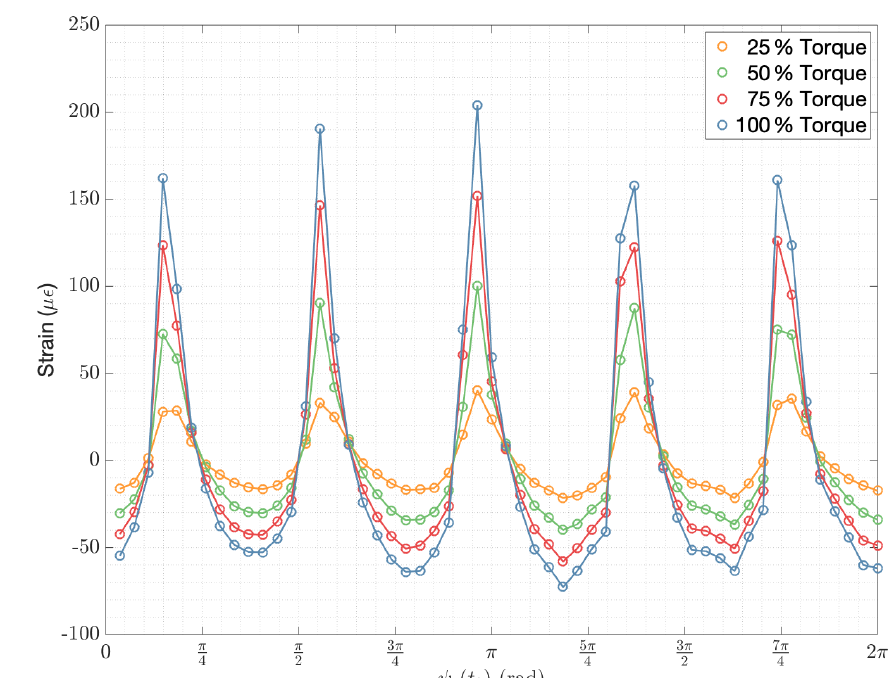
Figure 14. Instantaneous signal values of all 54 strain sensors for four different torque levels (25%, 50%, 75%, and 100% Torque).